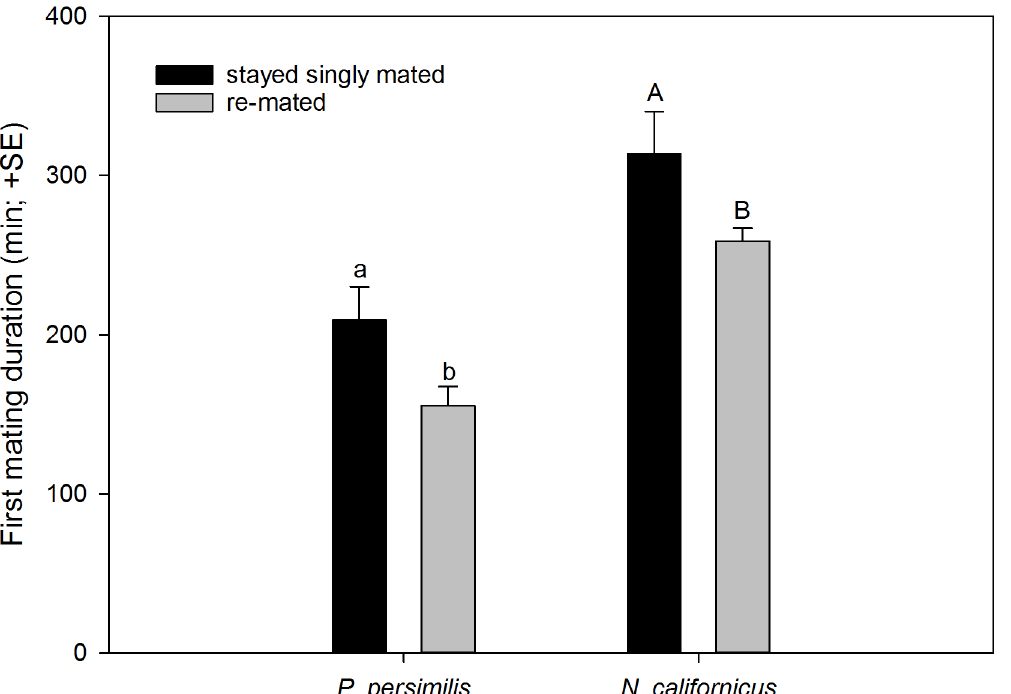
Fig 3. Re-mating propensity depends on duration of first mating. First mating duration of females of P . persimilis (N = 30) and N . californicus (N = 23), staying singly mated and re-mating, respectively. Different letters on top of bars indicate significant differences between singly mating and re-mating females within species (GLM; P <